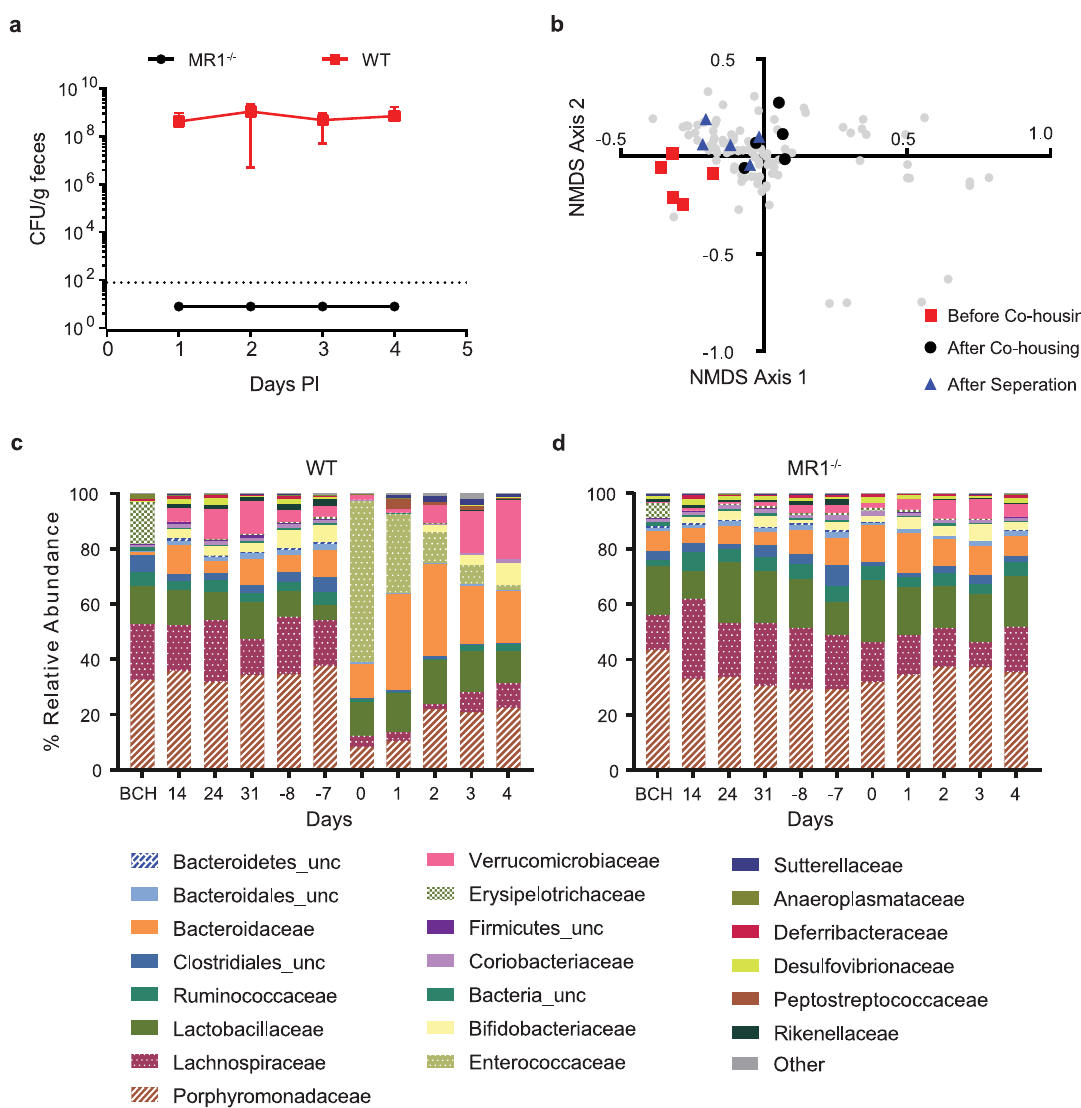
Fig 6. Altered Cd colonization resistance is not due to mouse strain breeding site differences. (A) WT and MR1 -/- mice were co- housed for one month, separated for three weeks, and then put through the cefaperazone model of CDI. Colonization levels were determined for four days PI. Data presented are mean ± SD. WT n = 5 MR1 -/- n = 6. (B) β -diversity throughout co-housing. 2-D non- metric multidimensional scaling (NMDS) plot of ThetaYC distances for all samples collected during the experiment. WT samples taken before, on the last day of co-housing, and on the last day of separation are highlighted in red, black and blue, respectively. Remaining samples are depicted gray. Relative abundance of microbiota present in WT n = 5 (C) and MR1 -/- n = 6 (D) mice before co-housing (BCH), during (days 14, 24, and 31), three weeks after separation (day -8), upon initiation of cefoperazone treatment (day -7), after cefoperazone treatment (day 0), and after Cd inoculation (days 1–4).